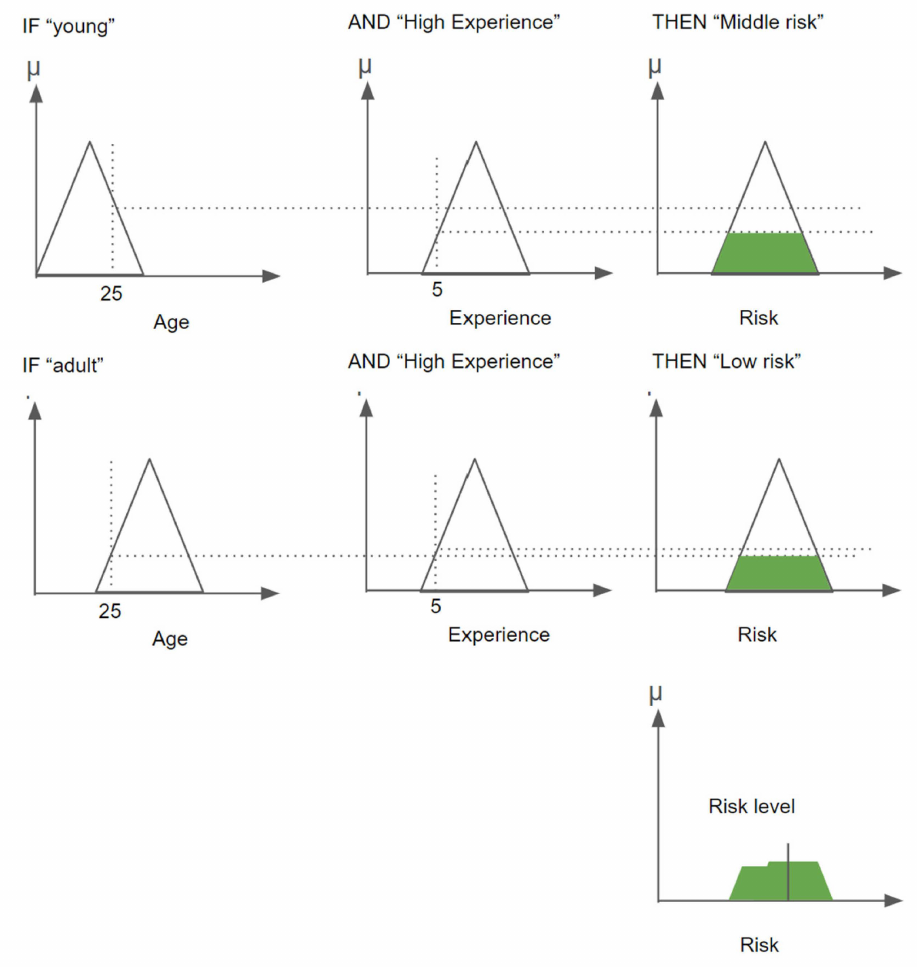
Figure 1. Graphic interpretation of system